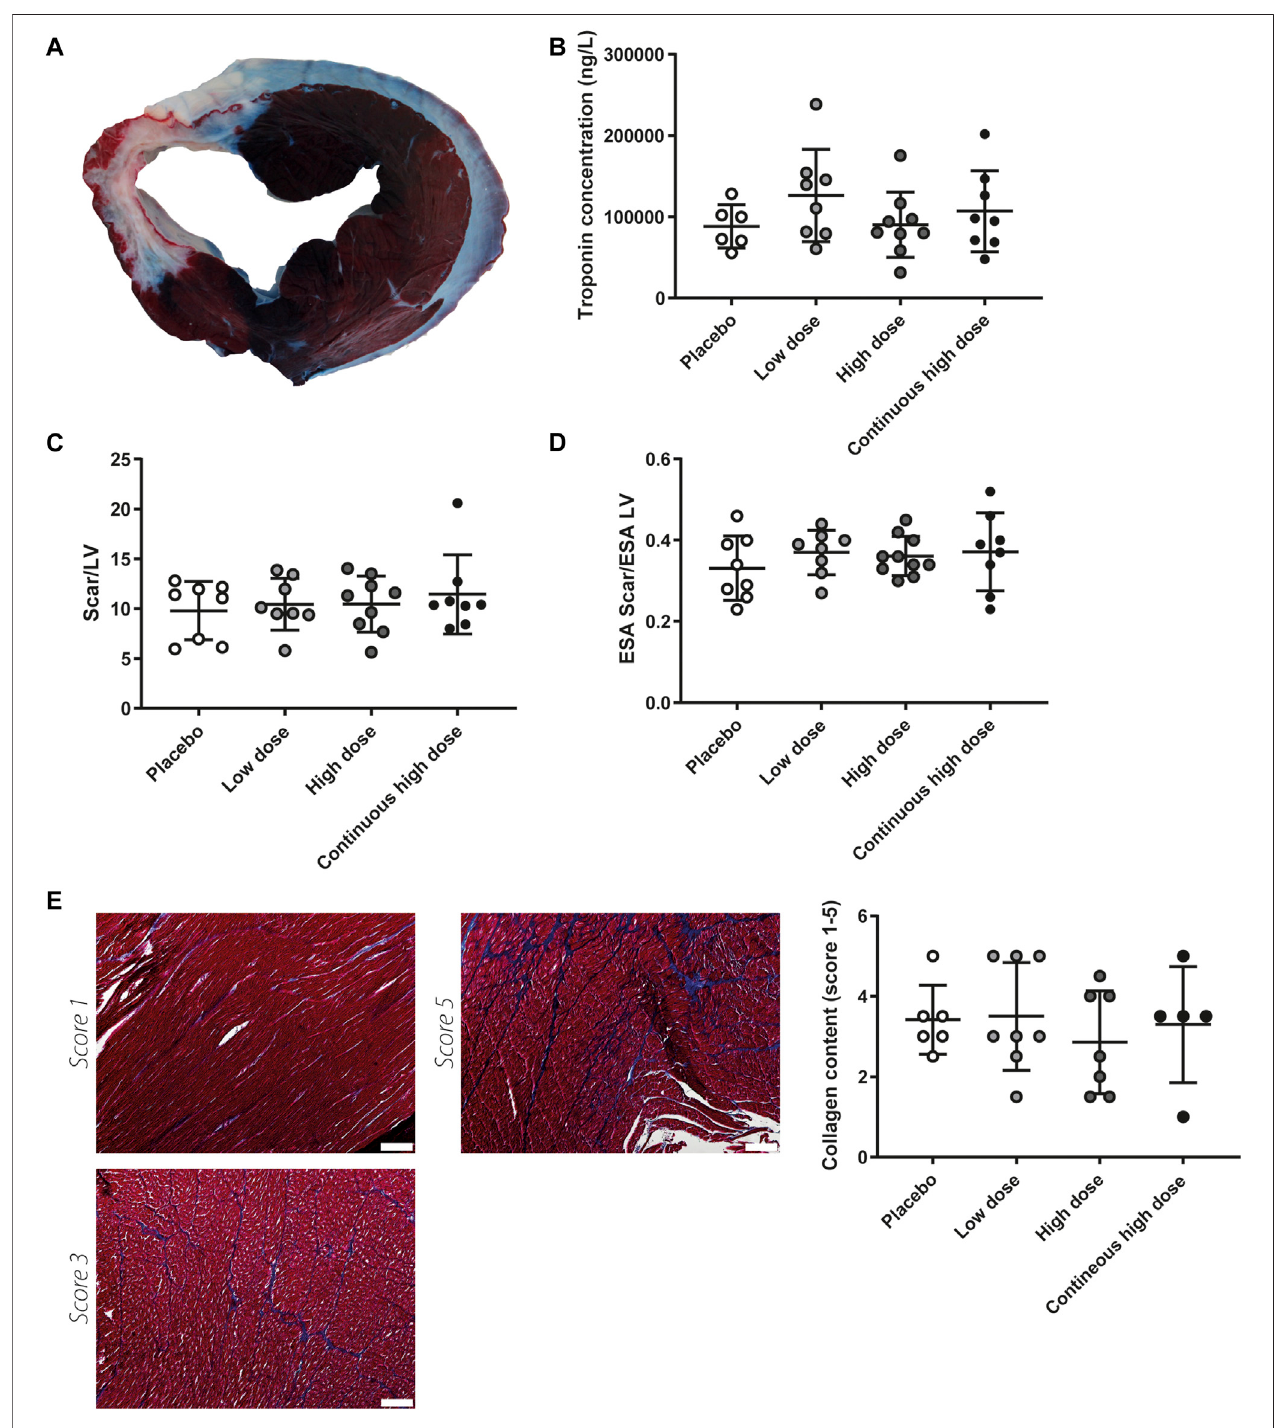
FIGURE 2 | Myocardial damage and after severe ischemia-reperfusion injury. (A) Representative picture of myocardial slice; the dark area represents the remote area,whitearearepresentsinfarcted myocardium. (B) Circulating levels ofcardiac troponin 24 h after severe ischemia-reperfusion injury. No signi fi cantdifferenceswere observedbetweenthedifferentexperimentalgroups. (C) Infarctedareasdidnotdifferbetweentreatmentgroupswhenexpressedrelativetomeasurementsleftventricle (LV) at 8 weeks follow-up. (D) Infarct area as a fraction of LV endocardial surface area (ESA) was not different between treatment groups at 8 weeks follow-up. (E) Representative pictures of collagen content score 1, score 3, and score 5 after staining with Masson ’ s Trichrome, quanti fi cation showed no differences in interstitial fi brosis in the border zone region. Scale bar (cid:2) 200 µm.